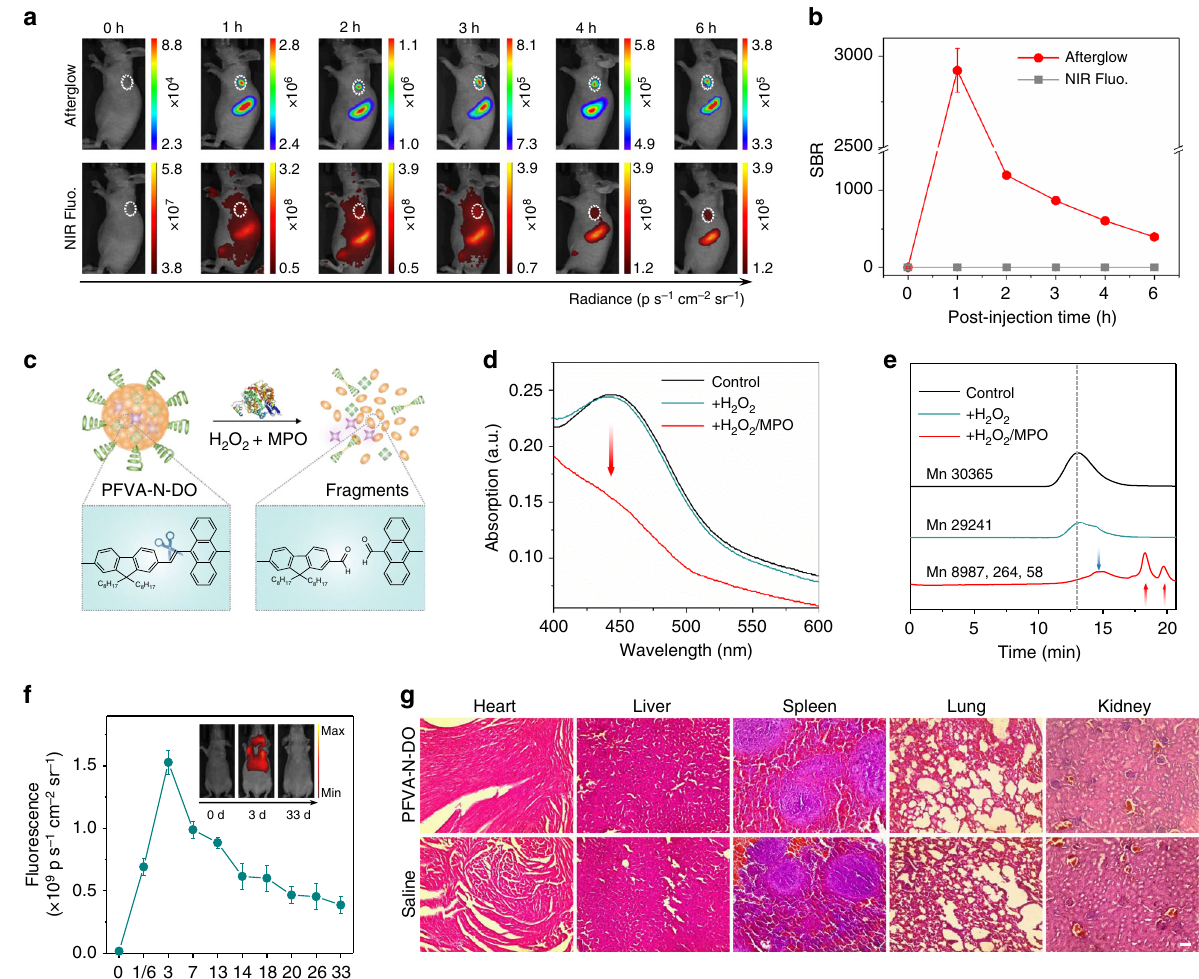
Fig. 5 In vivo imaging, biodegradation, and clearance studies of ALNPs. a Representative afterglow and NIR fl uorescence images of 4T1 xenograft tumor bearing mice at the different time points after tail vein injection of PFVA-N-DO ([PFVA] = 250 μ g mL − 1 , [DO] = 125 μ g mL − 1 , [NCBS] = 6.25 μ g mL − 1 , 250 μ L). Afterglow images were acquired after pre-irradiation of mice at 808 nm laser for 5 s (0.3 W cm − 2 ). Fluorescence images were acquired at 780 nm upon excitation at 710 nm. White dashed circles indicated location of tumor. b SBRs of afterglow and NIR fl uorescence imaging in tumor region as a function of time in ( a ). c Proposed mechanism of biodegradation of PFVA-N-DO nanoparticles by the mixture of MPO and H 2 O 2 . d Absorption spectra of PFVA-N-DO ([PFVA] = 4 μ g mL − 1 ) after incubation with buffer (control), H 2 O 2 (300 mM), or MPO (50 μ g mL − 1 )/H 2 O 2 (300 mM) at 37 °C for 24 h in 100 mM PBS (pH = 7.0). e GPC results of ALNP solutions in ( d ). f Quanti fi cation of the NIR fl uorescence intensities of liver region in living mice as a function of time after intravenous injection of PFVA-N-DO ([PFVA] = 250 μ g mL − 1 , [DO] = 125 μ g mL − 1 , [NCBS] = 6.25 μ g mL − 1 , 250 μ L). NIR fl uorescence images were acquired at 780 nm upon excitation at 710 nm. g Hematoxylin & eosin staining of major organs from mice after tail vein injection of PFVA-N-DO ALNPs ([PFVA] = 250 μ g mL − 1 , [DO] = 125 μ g mL − 1 , [NCBS] = 6.25 μ g mL − 1 , 250 μ L) or saline (250 μ L) for 33 days. Scale bar: 50 µ m. Error bars indicated standard deviations of three separate measurements ( n =